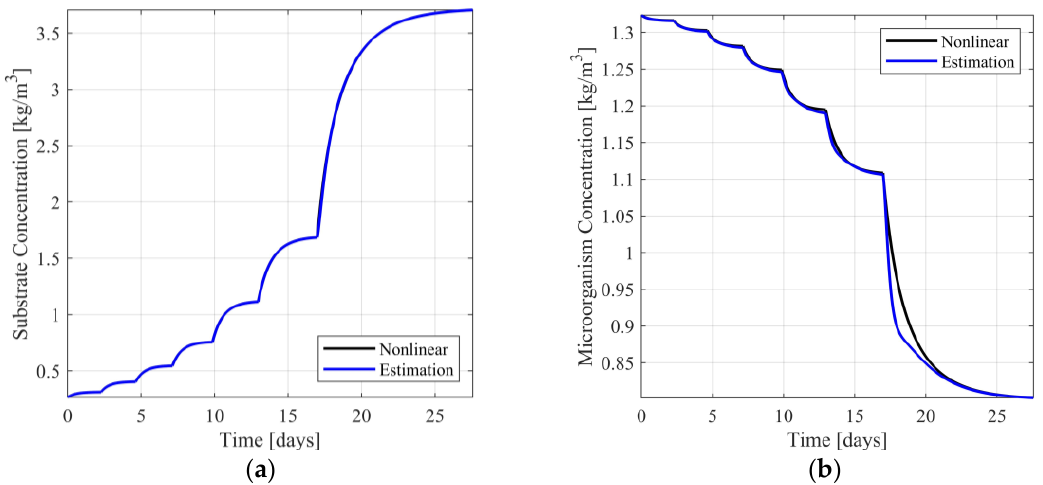
Figure 7. ( a ) Substrate concentration response and estimation; ( b ) Microorganism concentration re-